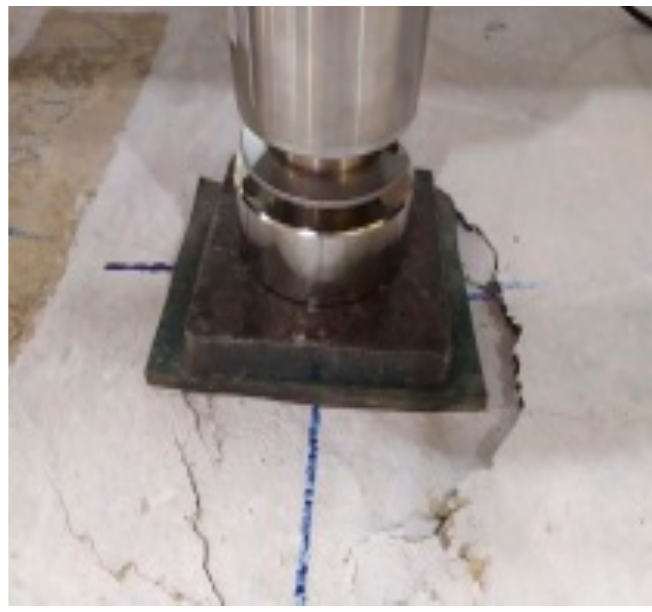
Figure 5. The set-up of the impact load test.